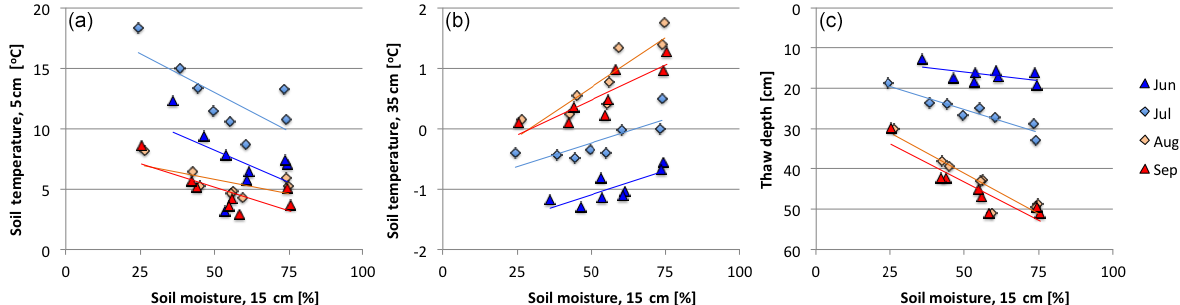
Figure 8. Influence of soil moisture on soil temperatures ( a : 5cm; b : 35cm) and thaw depth (c) at eight micro-sites covering both disturbance treatments. Observations from summer 2015 are aggregated by site over a period of about 2 weeks each (13–30 June; 1–13 July; 21– 31 August; 1–12 September). Lines represent linear regression fits to emphasize trends. Table 3. Energy flux components averaged over the summer months (June–September) within data years 2014 and 2015, including average and relative differences between drainage and control area